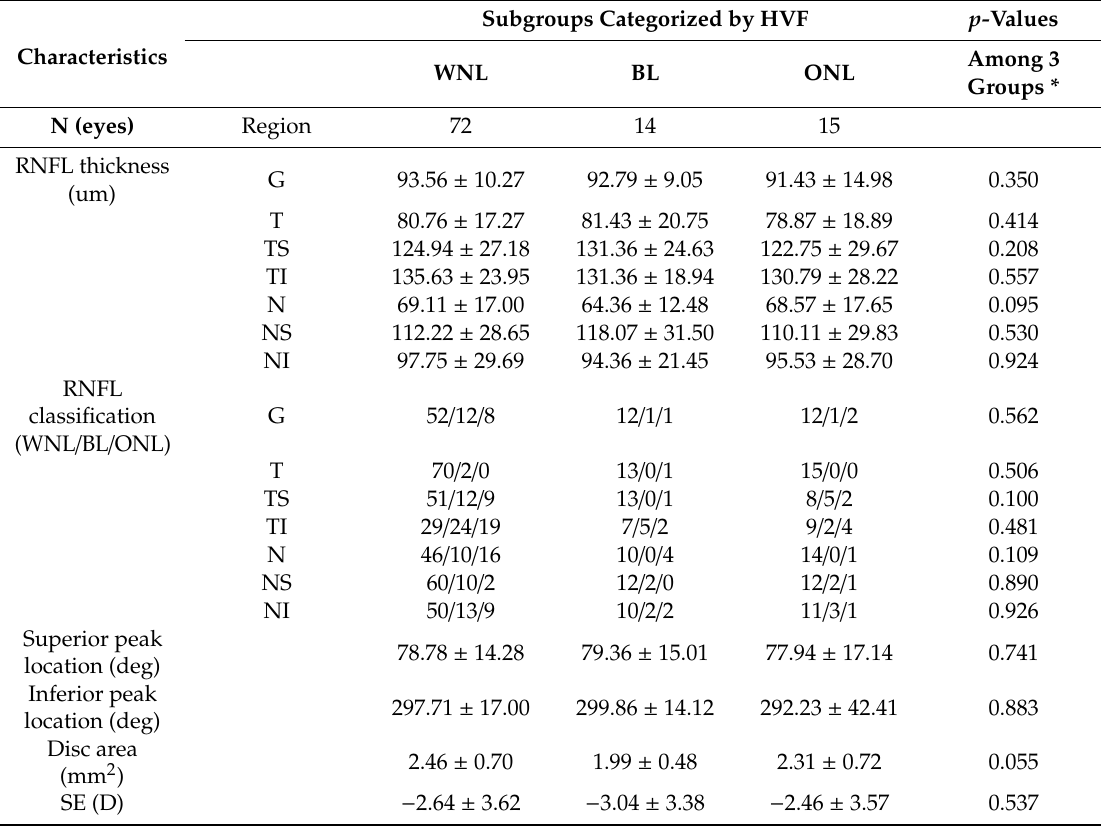
Table 6. Retinal nerve fiber layer according to visual field test